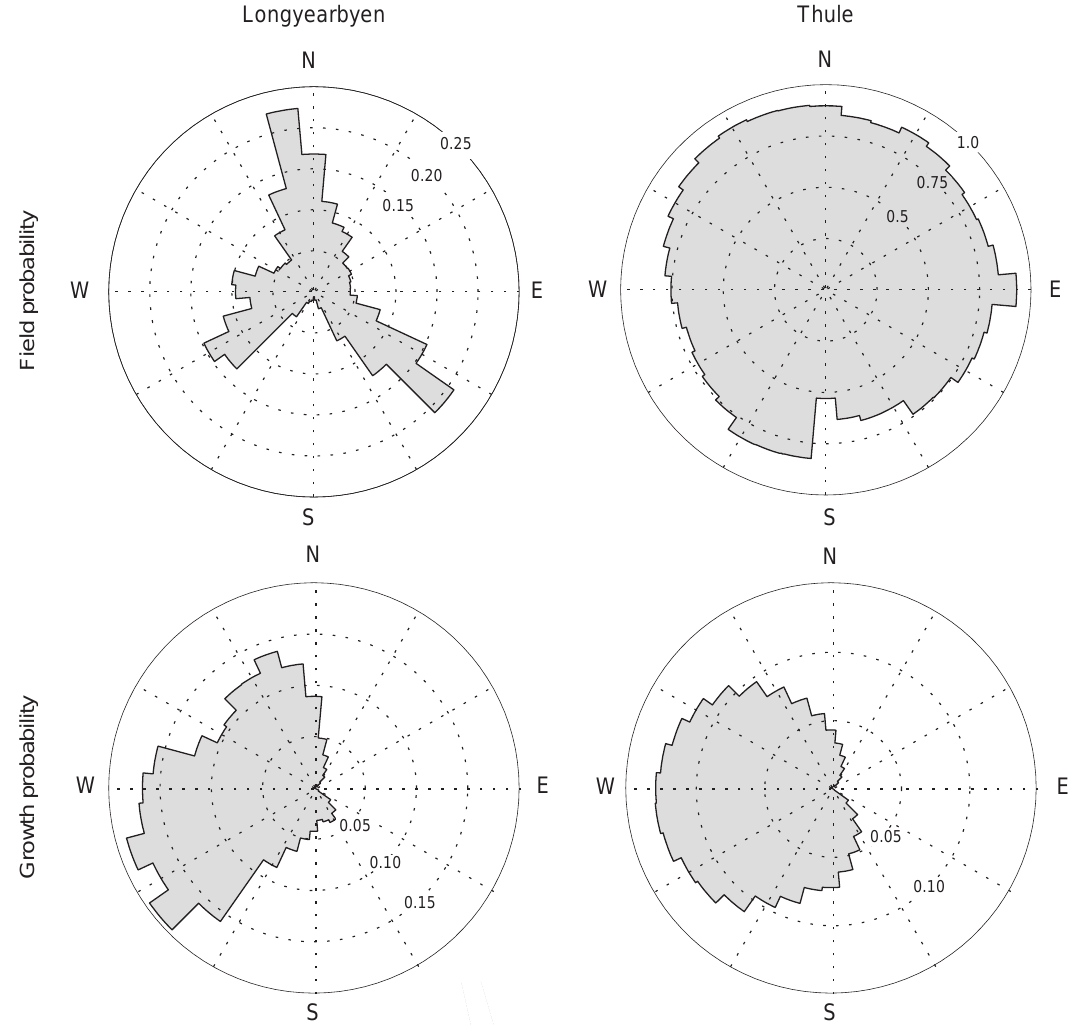
Fig. 7. Top panels: Unnormalised field probabilities for Longyearbyen (left) and Thule (right) for different directions of the electric field, calculated using the APL model. Bottom panels: Unnormalised growth probabilities for Longyearbyen and Thule, based on the layer growth shown in the bottom panels of Fig. 6. For definitions of “field probability” and “growth probability”, as well as details of the calculation, see the